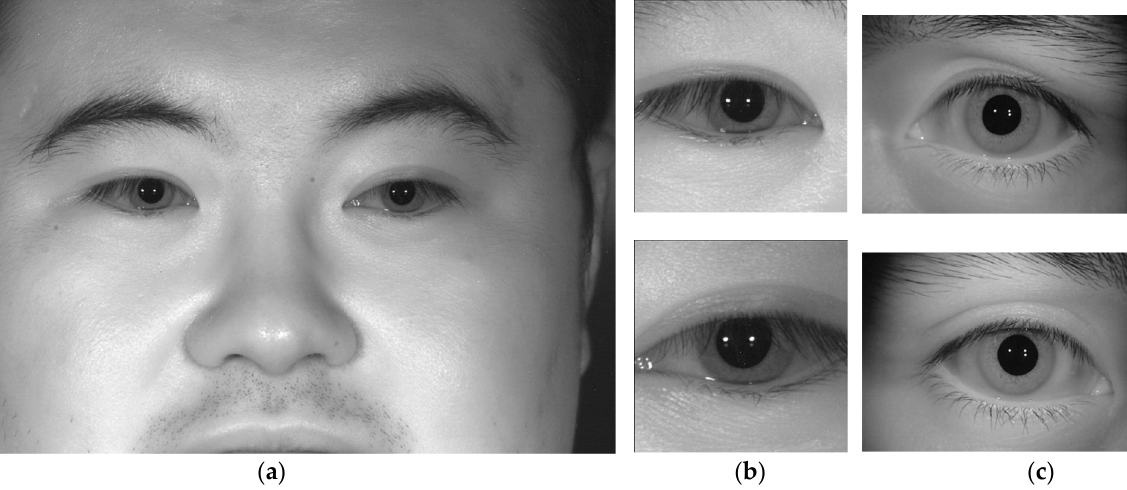
Figure 1. An example of the CASIA database that includes face or eye images. ( a ) Entire facial image from CASIA-iris-Distance v4 database; ( b ) iris region of interest (ROI) detected from ( a ); ( c ) iris image from the CASIA-iris-Lamp v4 database.